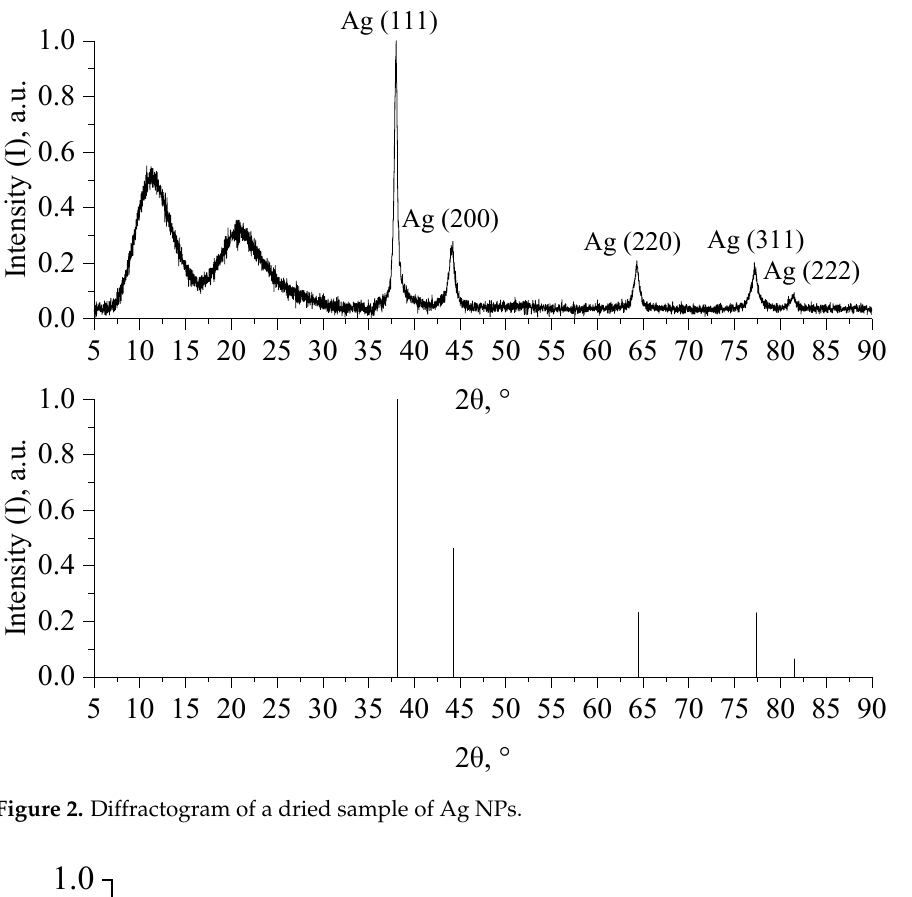
Figure 2. Diffractogram of a dried sample of Ag NPs. Diffractogram analysis showed that silver occurs as nanocrystallites with a cubic face ‐ centered crystal lattice, the spatial group Fm ‐ 3m, with unit cell parameters a = b = c = 0.409 nm. Wide bands in the area from 2 θ = 8° to 2 θ = 17° and from 2 θ = 17° to 2 θ = 25° correspond to PVP, which was used as a stabilizer of nanoparticles.